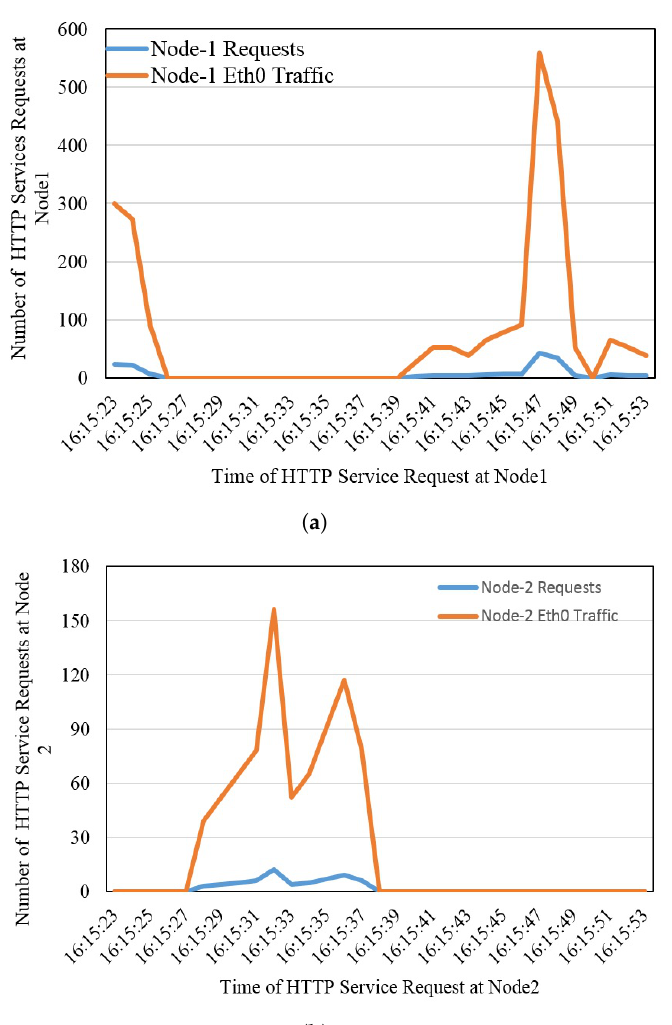
Figure 9. Antifragility and resiliency at the fog node level, ( a ) Fog node 1, and ( b ) Fog node